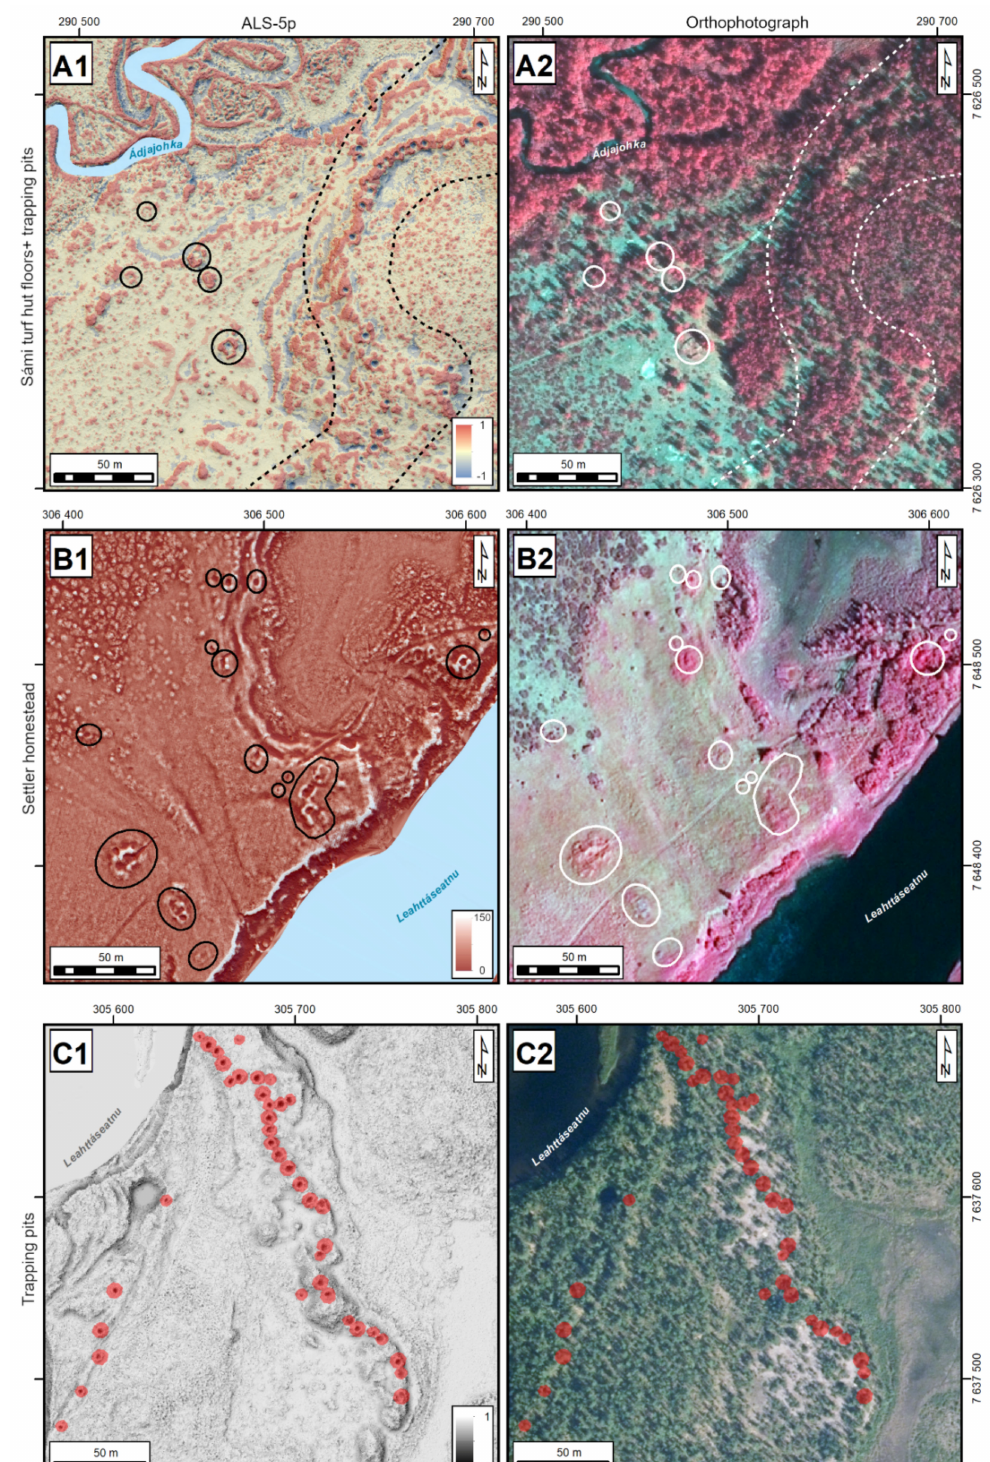
Figure 7. Examples of features documented from the ALS-5p visualizations [17] and orthophotos [20]. ( A1 , A2 ) Previously unregistered S á mi turf hut foundations (circled) and previously known pitfalls (bordered with a dashed line) at Á djajohka (area 6; ALS-5p: LRM+SVF+multi-HS). ( B1 , B2 ) A historical-era Finnish settler wilderness homestead with several turf hut foundations and other new features (circled) detected at Hirvasvuohppi (area 3; ALS-5p: Openness+multi-HS). ( C1 , C2 ) Part of a previously unregistered trapping system at Mohkkeguoika (area 4; highlighted in red as detected by the used U-Net Detector D1) (ALS-5p: SVF+multi-HS). (EPSG:3879 ETRS89/GK25FIN). (Illustration: Oula